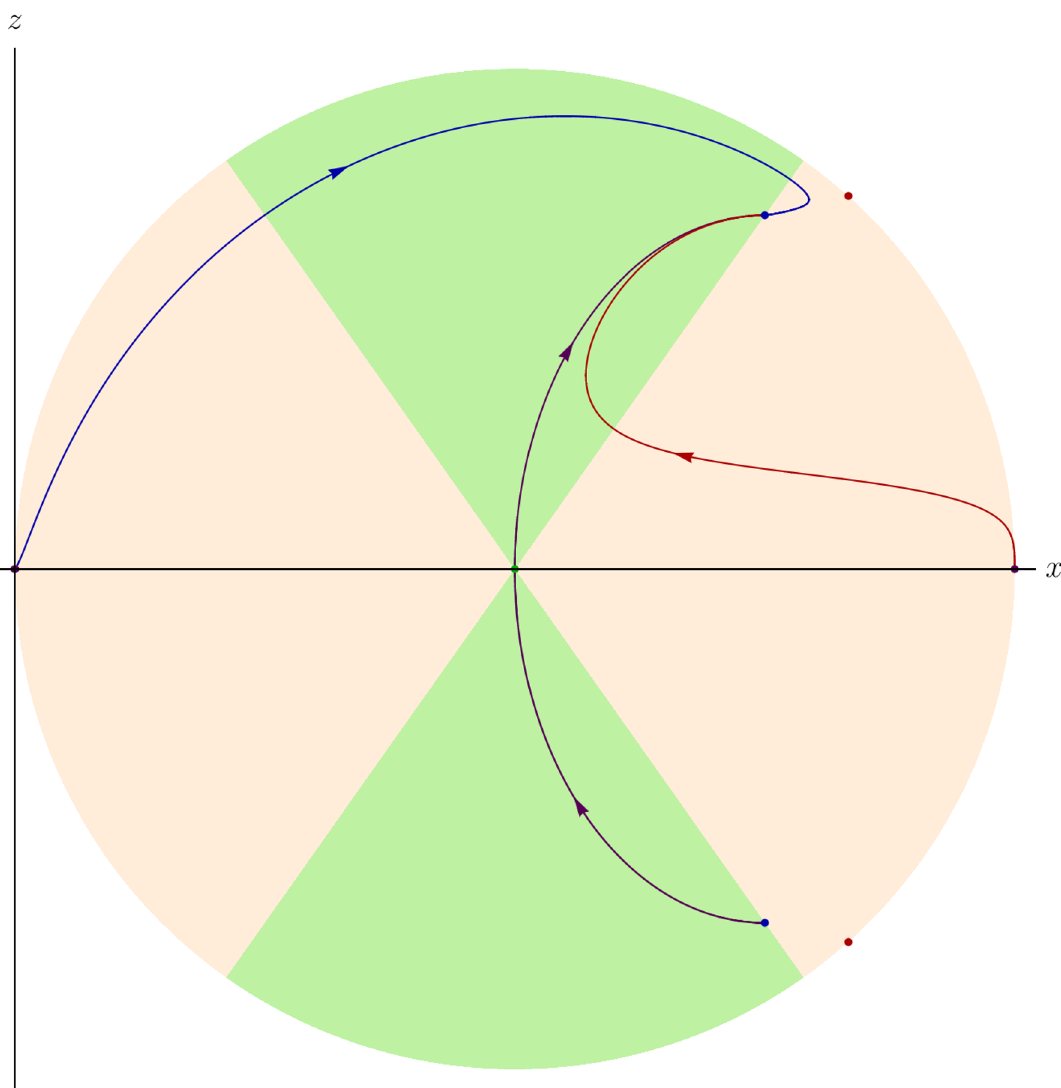
Figure 2 . Three trajectories lying on the invariant plane P of the dynamical system obtained from the compactification with k, λ 6 = 0 . The point p corresponding to a Milne universe is depicted in 0 green. The point p (and its mirror in the southern hemisphere) is drawn in blue and corresponds 1 to a Milne universe with angular defect. The equator fixed points coincide with a scaling cosmology with S ∼ T 1 and are illustrated in purple. The blue trajectory features transient acceleration with 3 tunable number of e-foldings, whereas the red one corresponds to semi-eternal acceleration. Depicted in purple is the unique (fine-tuned) trajectory corresponding to eternal acceleration. The solution becomes de Sitter in the vicinity of the origin, which is reached at finite proper time. The solution can be geodesically completed in the past beyond the point at the origin, by gluing together its mirror trajectory in the southern